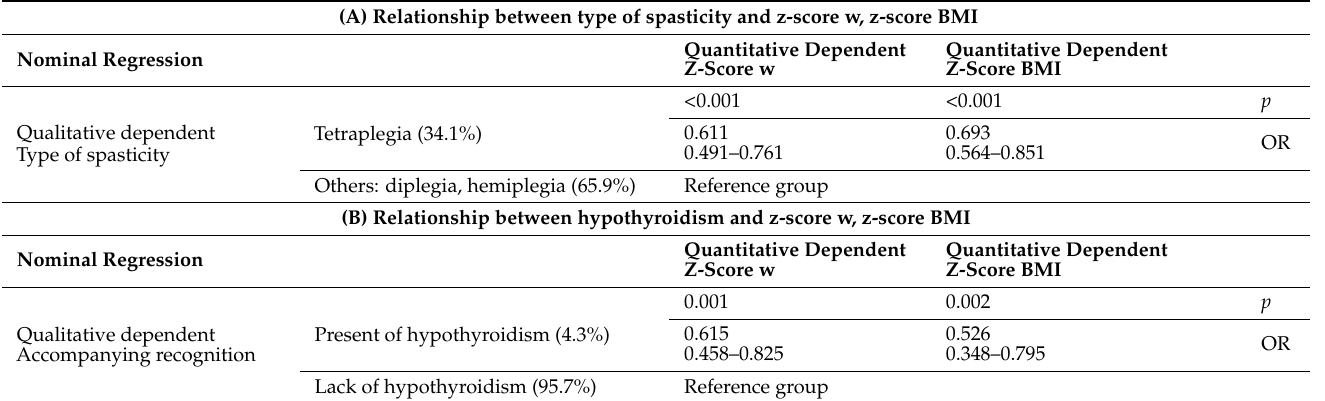
Present of hypothyroidism